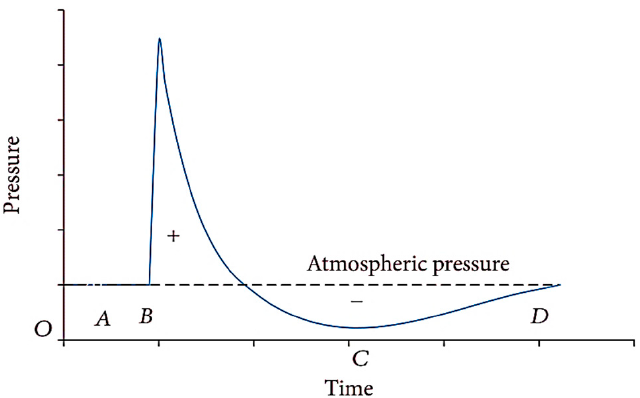
Figure 1. Pressure time history for free explosion [9].